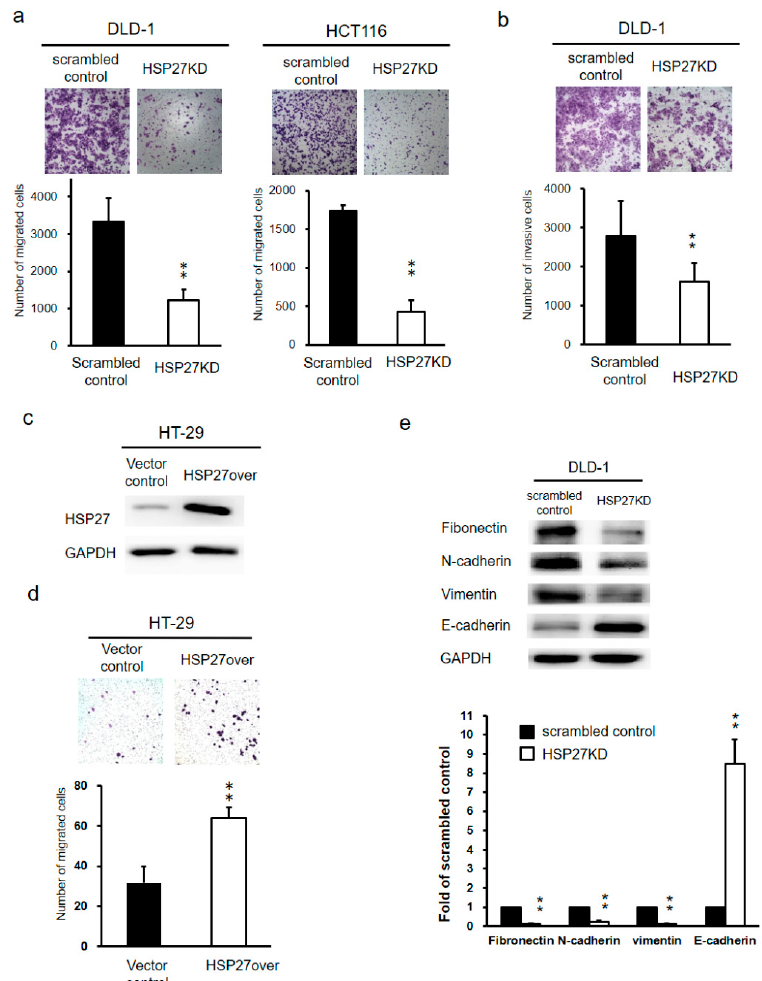
Figure 5. Silenced HSP27 suppressed the migratory and invasive abilities of CRC cells. The migratory ( a ) or invasive ( b ) ability was determined in scrambled control and HSP27KD CRC cells. ( c ) HSP27 was overexpressed in HT-29 cells. HSP27 levels were determined by western blot analyses. ( d ) Overexpression of HSP27 in HT-29 cells enhanced the migratory ability. ( e ) EMT-related biomarkers (Fibronectin, N -cadherin, vimentin, E-cadherin) were determined by western blot analyses in the scrambled control and HSP27KD cells. The signal of target proteins was quantified and normalized to that of the internal control. The number of scrambled control samples was adjusted to 1. All experiments were independently repeated three times. ** indicates p < 0.01.